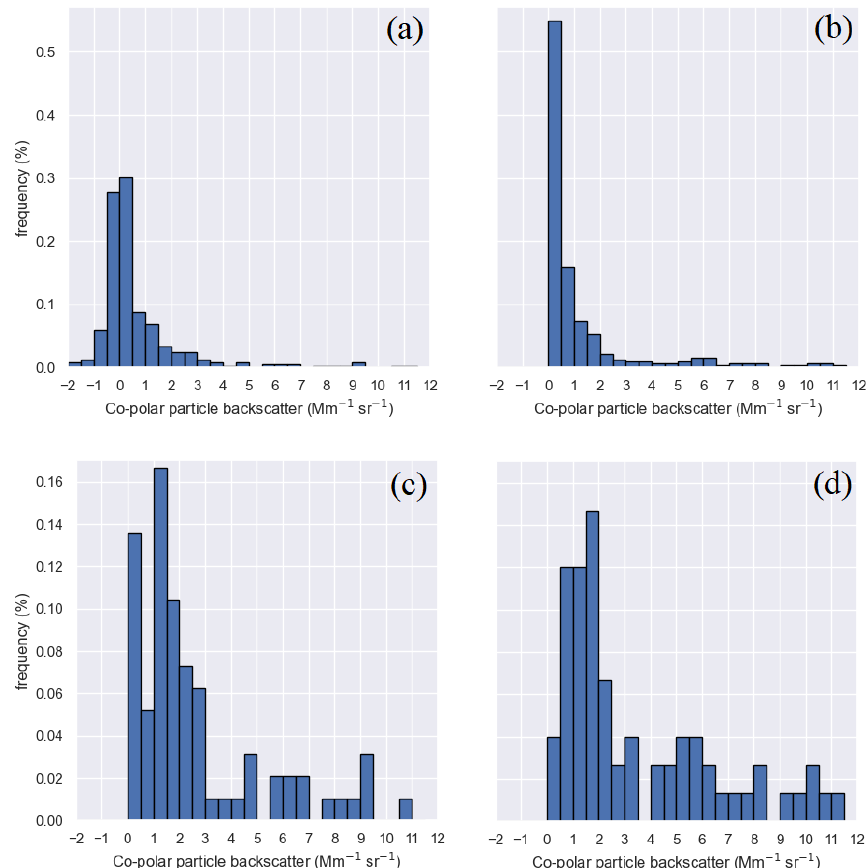
Figure 13. Histograms for the dataset, considering the three stations, of (a) the Aeolus SCA co-polar backscatter coefficient without the implementation of quality flags and (b) the Aeolus SCAmb co-polar backscatter coefficient without the implementation of quality flags. Panels (c) and (d) are the same as panels (a) and (b) , respectively, but considering quality